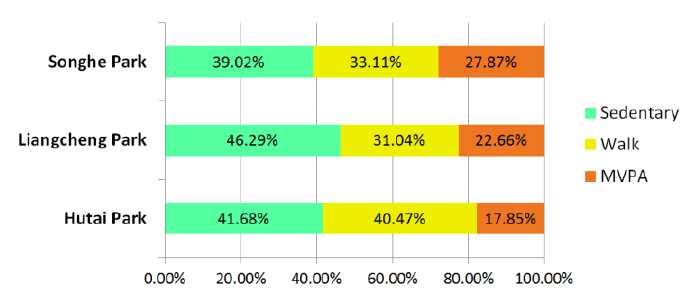
Figure 5. Percentage of the observed park users participating in the different levels of physical activity.